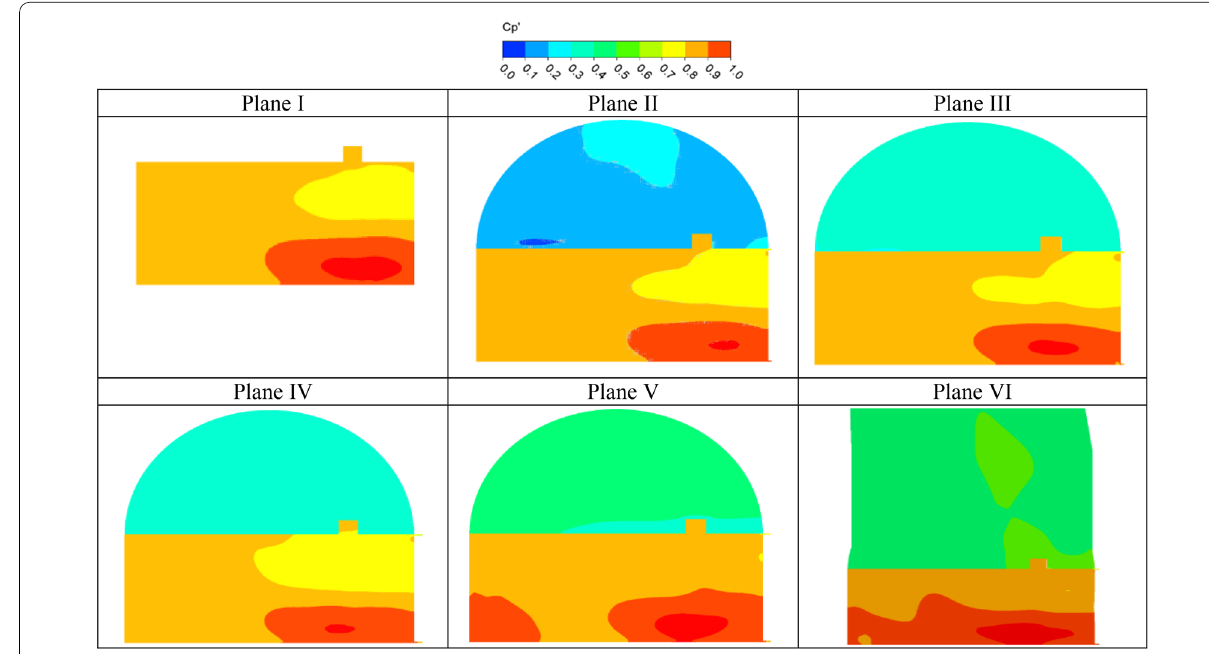
Figure 19 Distributions of pressure pulsation intensity coefficients on longitudinal planes